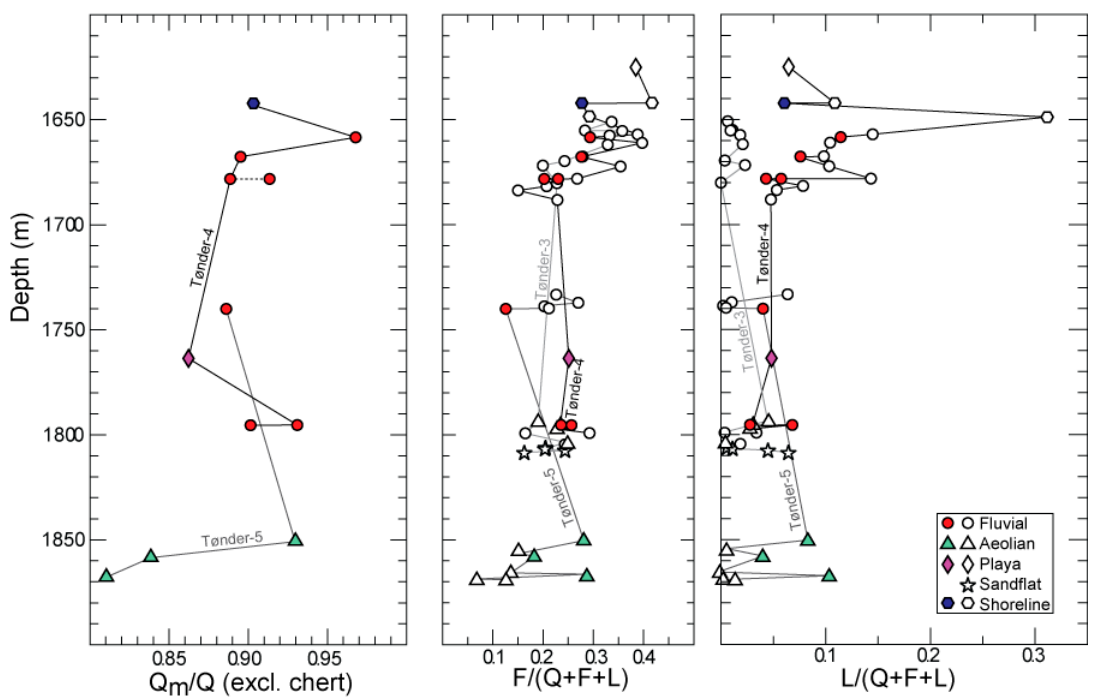
Figure 8. Grain-size and facies compositional trends for Early Triassic sandstone in wells Tønder-3, Tønder-4, and Tønder 5 (Denmark) based on data from Weibel and Friis [38] (coloured symbols) and Olivarius et al. [37] (white and grey symbols). Samples from the same depth are connected with dotted lines (best visible in the left-most diagrams). Samples from both studies were used together to evaluate compositional trends as care was taken to make the results from the two operators coherent [129]. Among the few rock fragments, sedimentary and plutonic or unspecified igneous grains dominate [37,38]. F: feldspar; L: lithic/rock fragments (poly-mineralic grains only; no carbonate clasts were detected); Q: quartz (both monocrystalline and polycrystalline grains); Q m : monocrystalline Q.